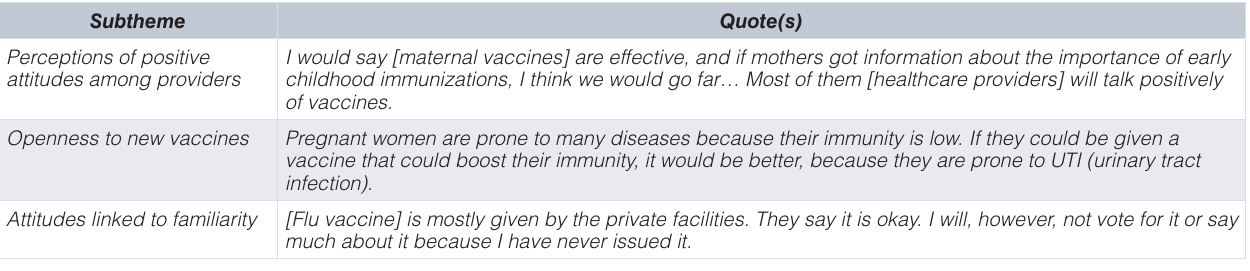
Table 5. Favorable attitudes toward maternal vaccines.